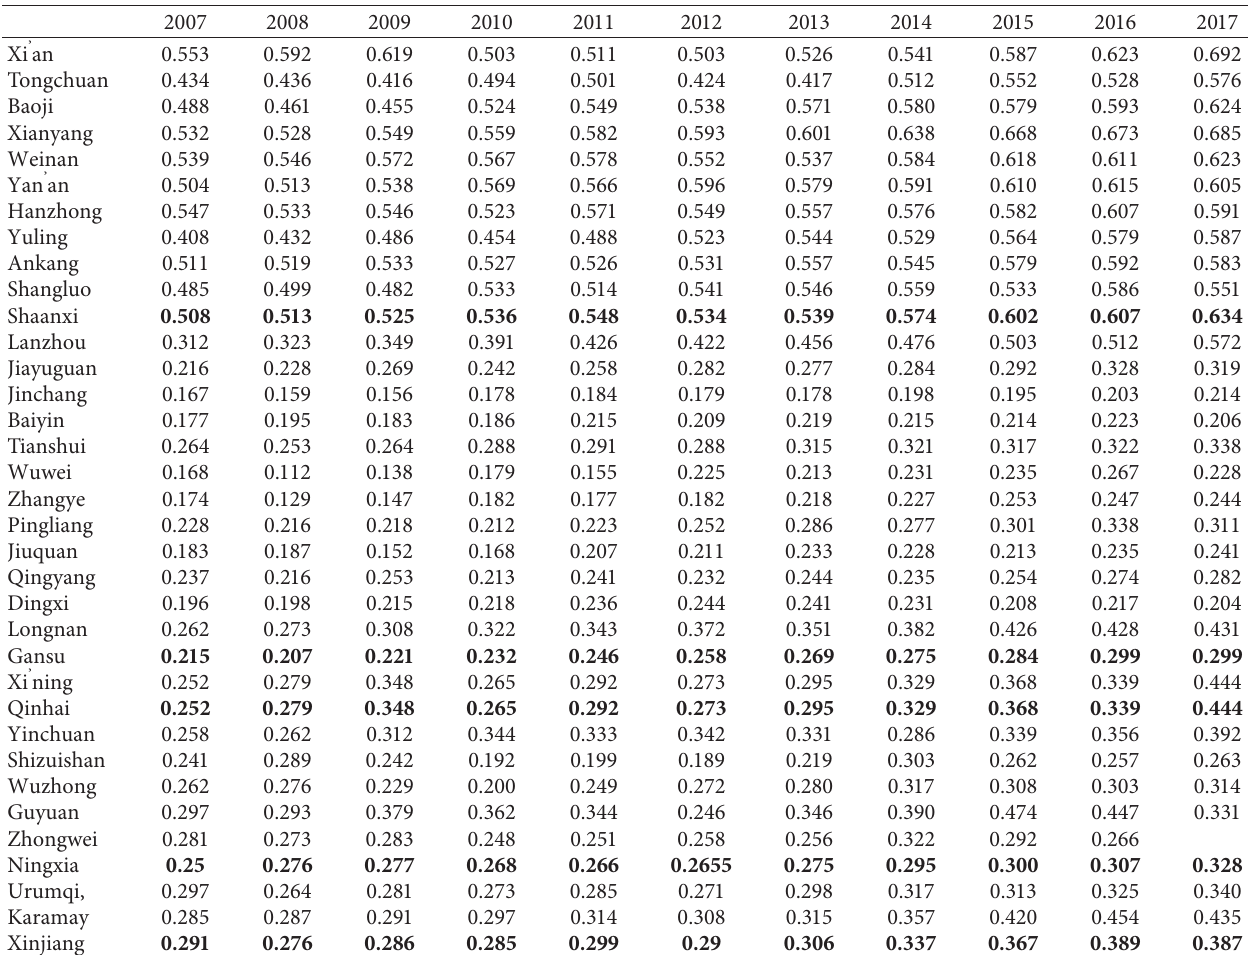
Table 2: Green development efficiency of prefecture-level cities in Northwest